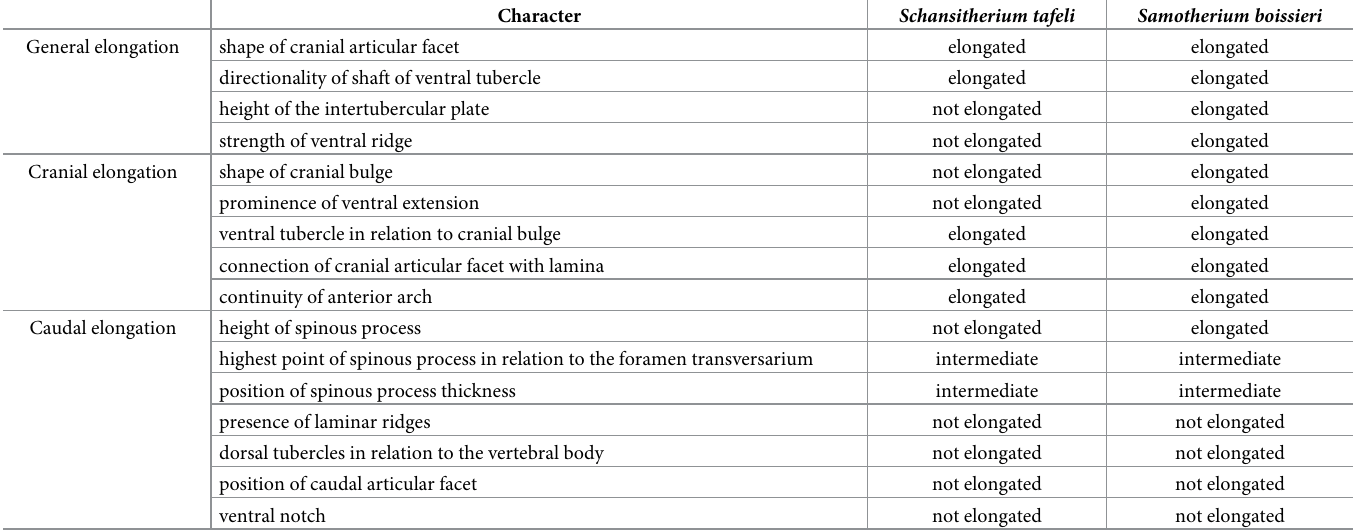
Table 3. Evaluation of cervical